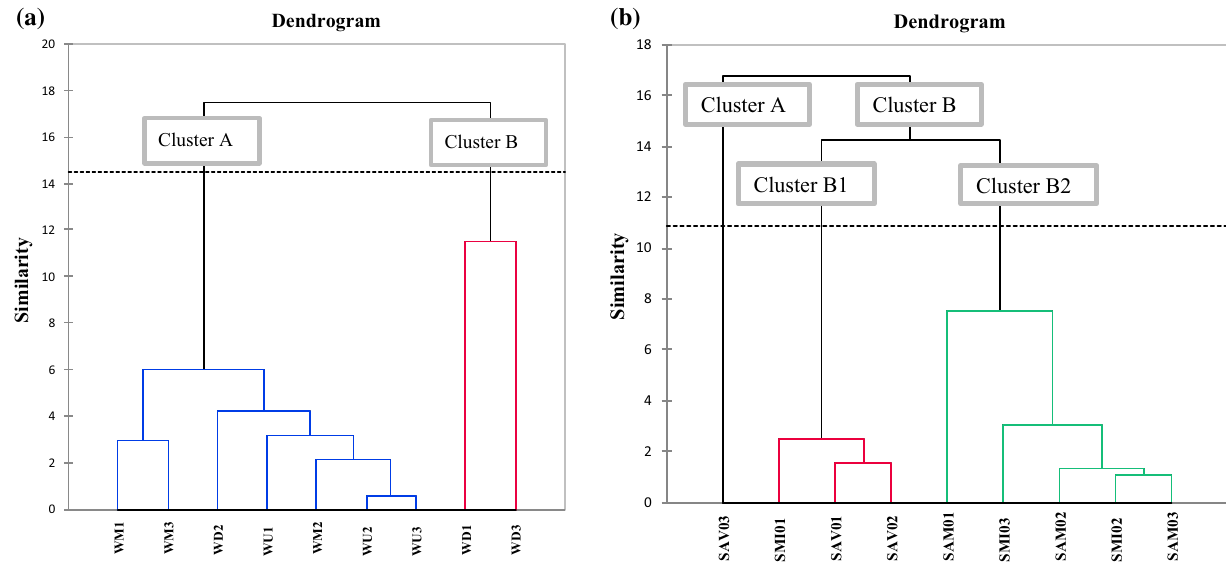
Fig. 8 Results of hierarchical cluster analysis (HCA): a Water samples and ( b ) Sediment